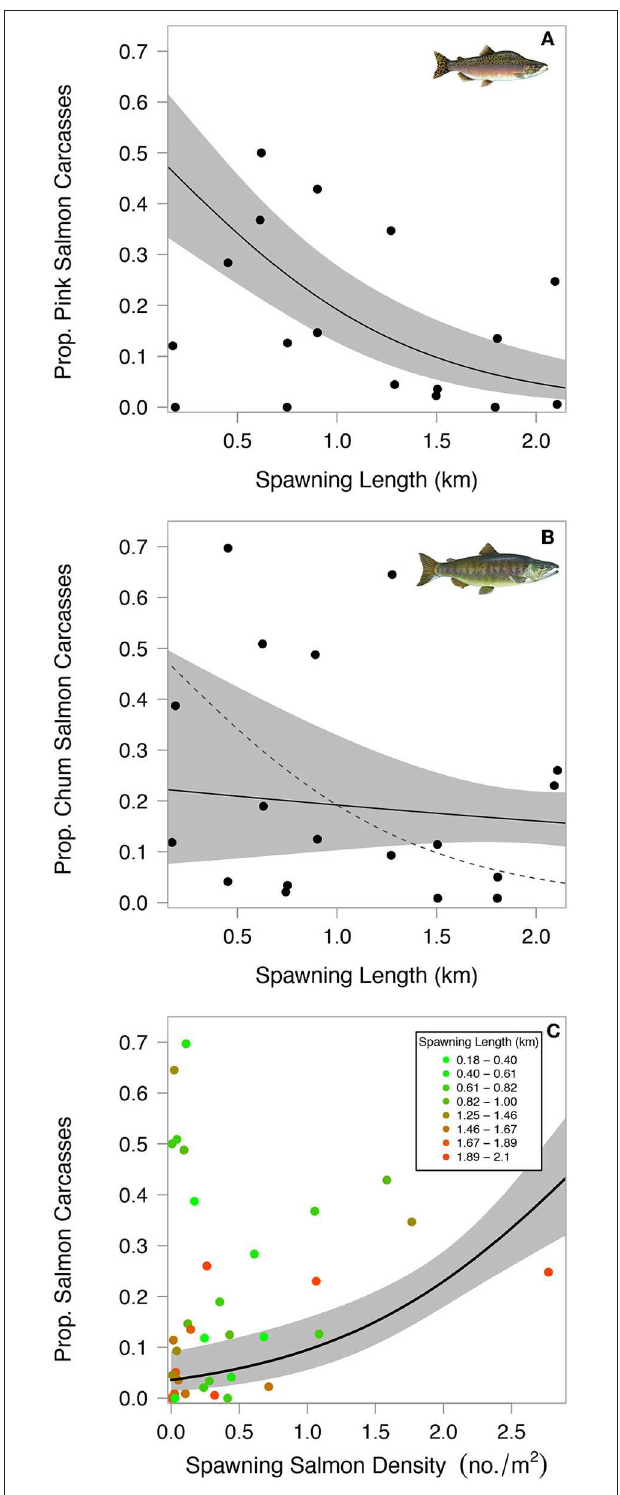
FIGURE 8 | Proportion of salmon carcasses in estuaries relative to total spawning channel length for pink salmon (A) and chum salmon (B) . Proportion of salmon carcasses in estuaries as a function of total salmon density (C) . Raw